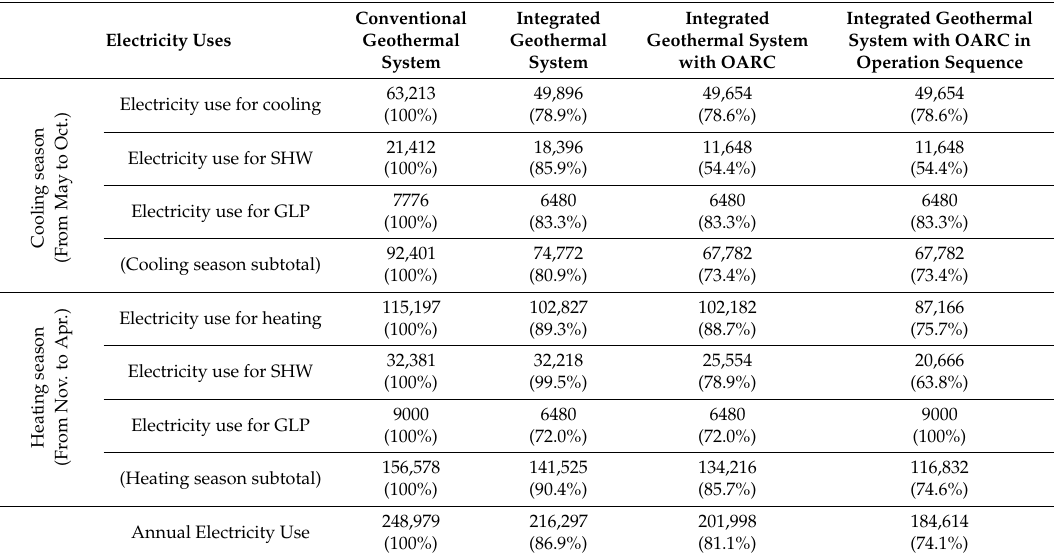
Table 5. Estimated annual electricity use by the four configurations (unit: